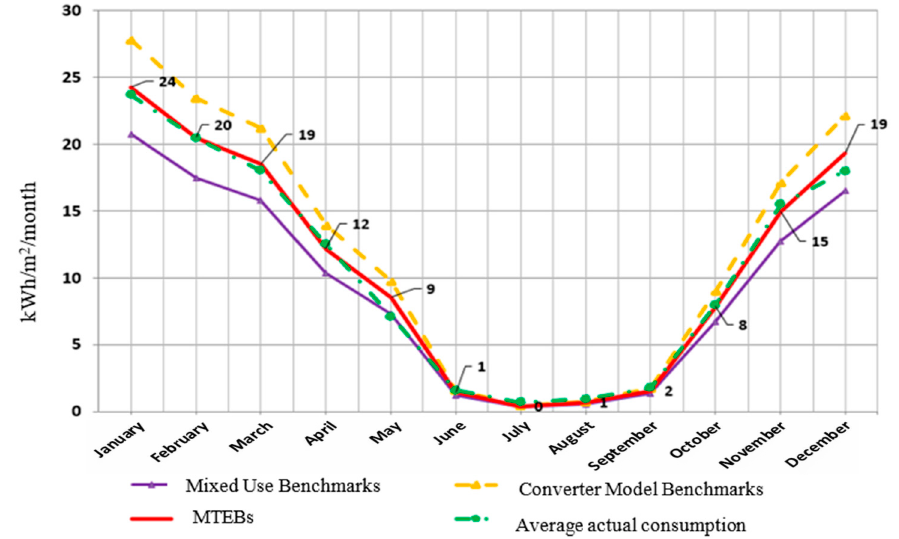
Figure 7. Monthly thermal energy benchmarks (MTEBs) for typical college buildings.